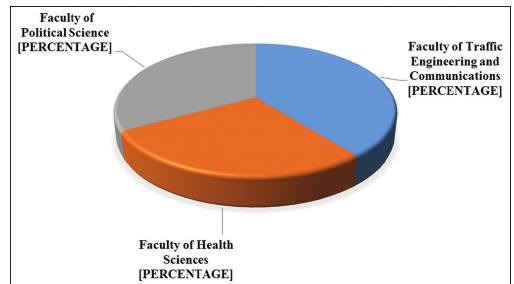
FIGURE 1. The ratio of participants by enrolled faculty.